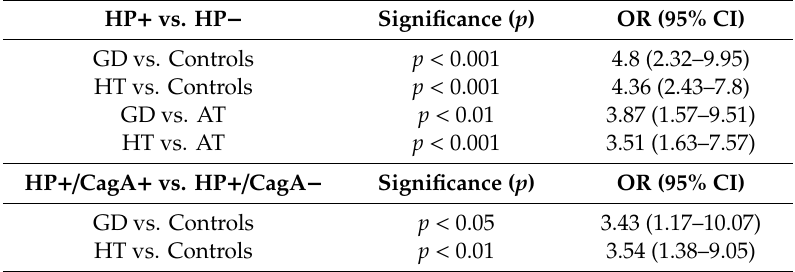
Table 2. Fisher’s exact test p -value and odds ratio (OR) for determining prevalence of overall H. pylori and CagA-positive H. pylori infection in patients with AITDs and controls.